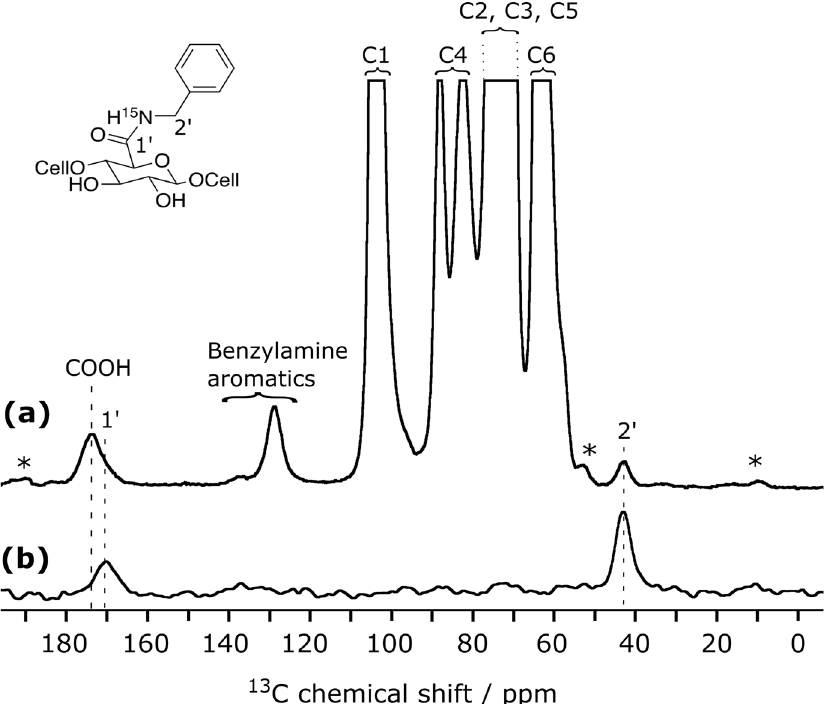
Fig. 3 DNP-enhanced {15N}-13C NMR of surface-functionalized CNF. DNP-enhanced a { 1 H}- 13 C CPMAS spectrum and b { 15 N}- 13 C TEDOR spectrum of 15 N-enriched benzylamine functionalized onto CNF. The resonance at 170 ppm in ( b ) con fi rms the amide bond formation. Resonance at 175 ppm in ( a ) is assigned to the unreacted carboxylic acid groups. Asterisks indicate spinning